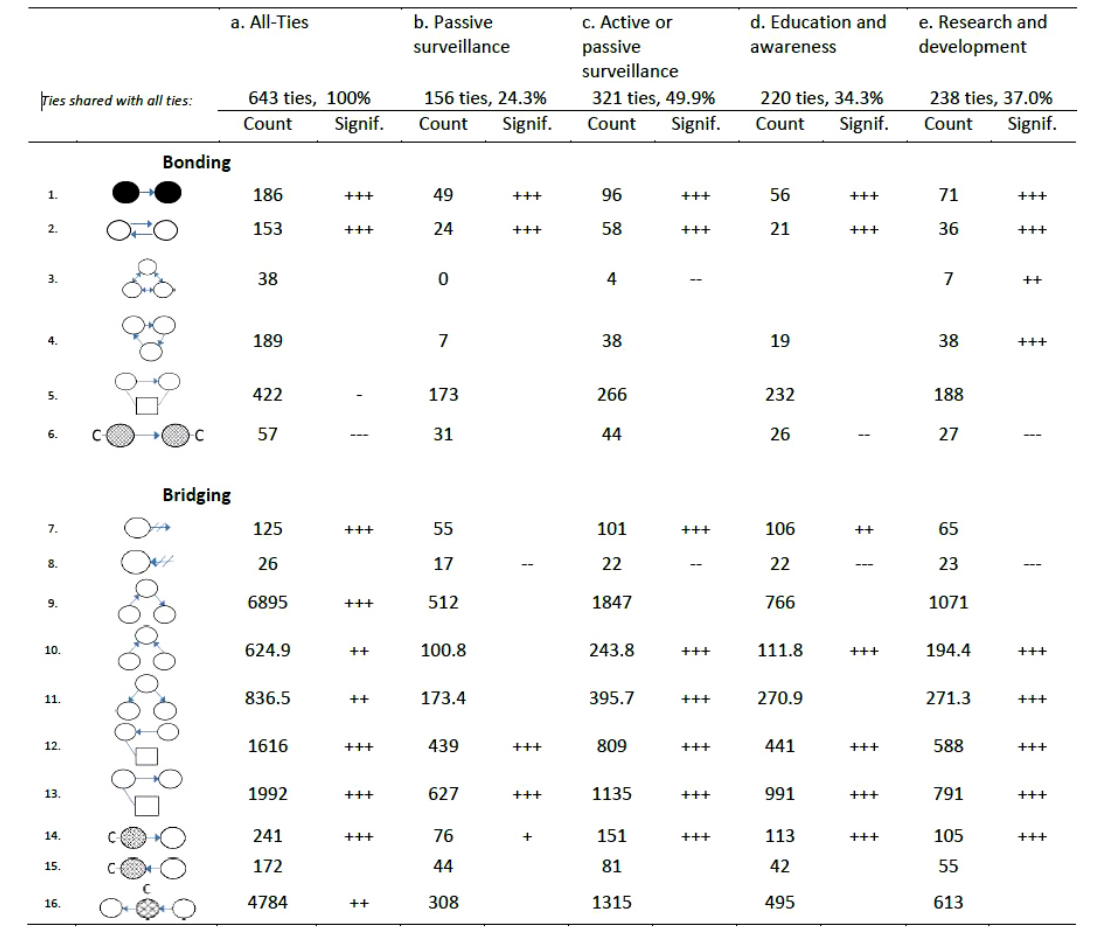
Fig. 4 . Over and under-representation of configurations. With +/++/+++ representing 90/95/99% significance for overrepresentation (- indicating under). For full results see Appendix 1, noting these results come from both exponential random graph model (Table A1.1) or goodness-of-fit (Table A1.2). The model fixes the structure of forum participation. Configurations [9] and [10] are both weighted configurations. See AinSA/AoutSA from Wang et al.